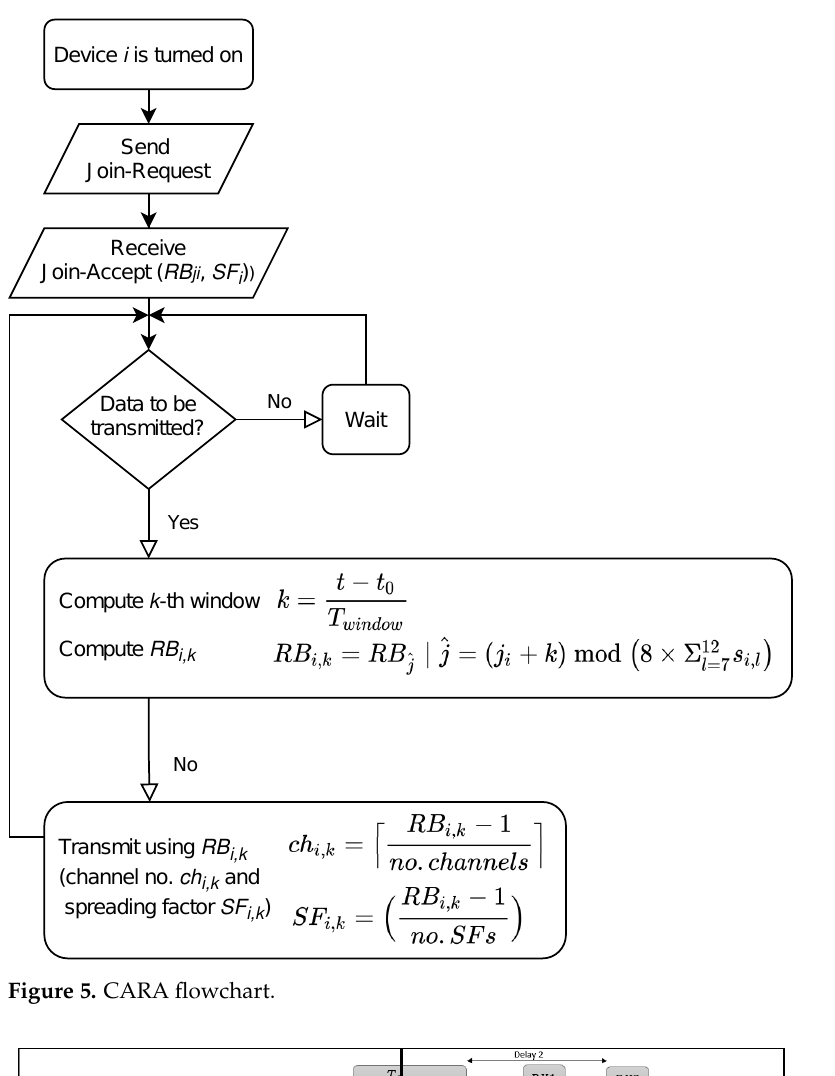
Figure 5. CARA flowchart.